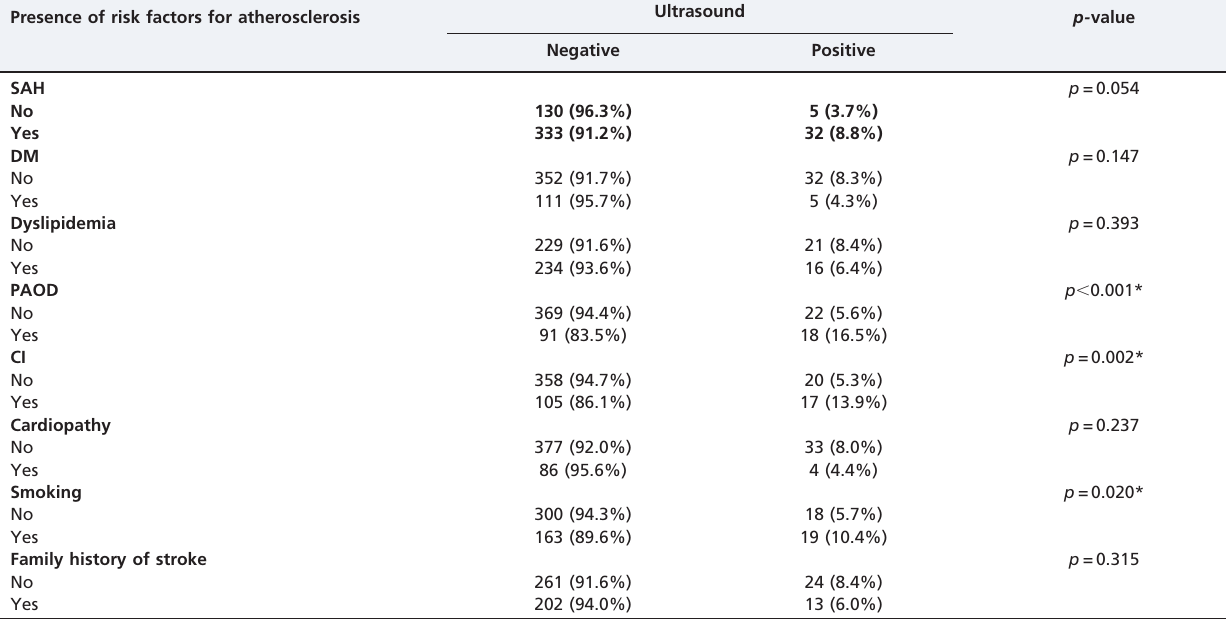
Table 2 - Comparison of variables considered risk factors for atherosclerosis between the groups that were positive and negative for carotid stenosis on ultrasound.